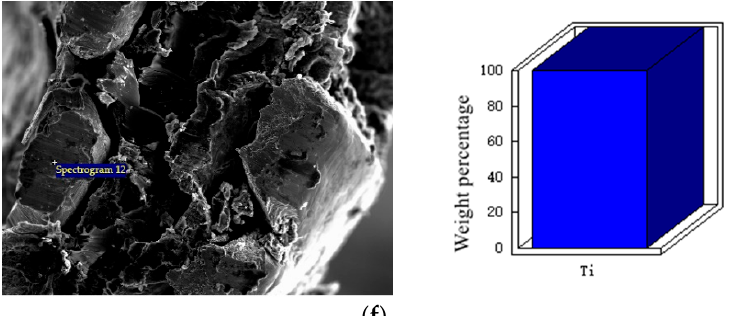
Figure 8. EDX analysis diagram of each layer in the cross-section of titanium mesh-based MEA. ( a ) Cathode substrate; ( b ) cathode gas diffusion layer; ( c ) cathode catalytic layer; ( d ) Nafion 117 mem- brane; ( e ) anode catalytic layer; ( f ) anode substrate.